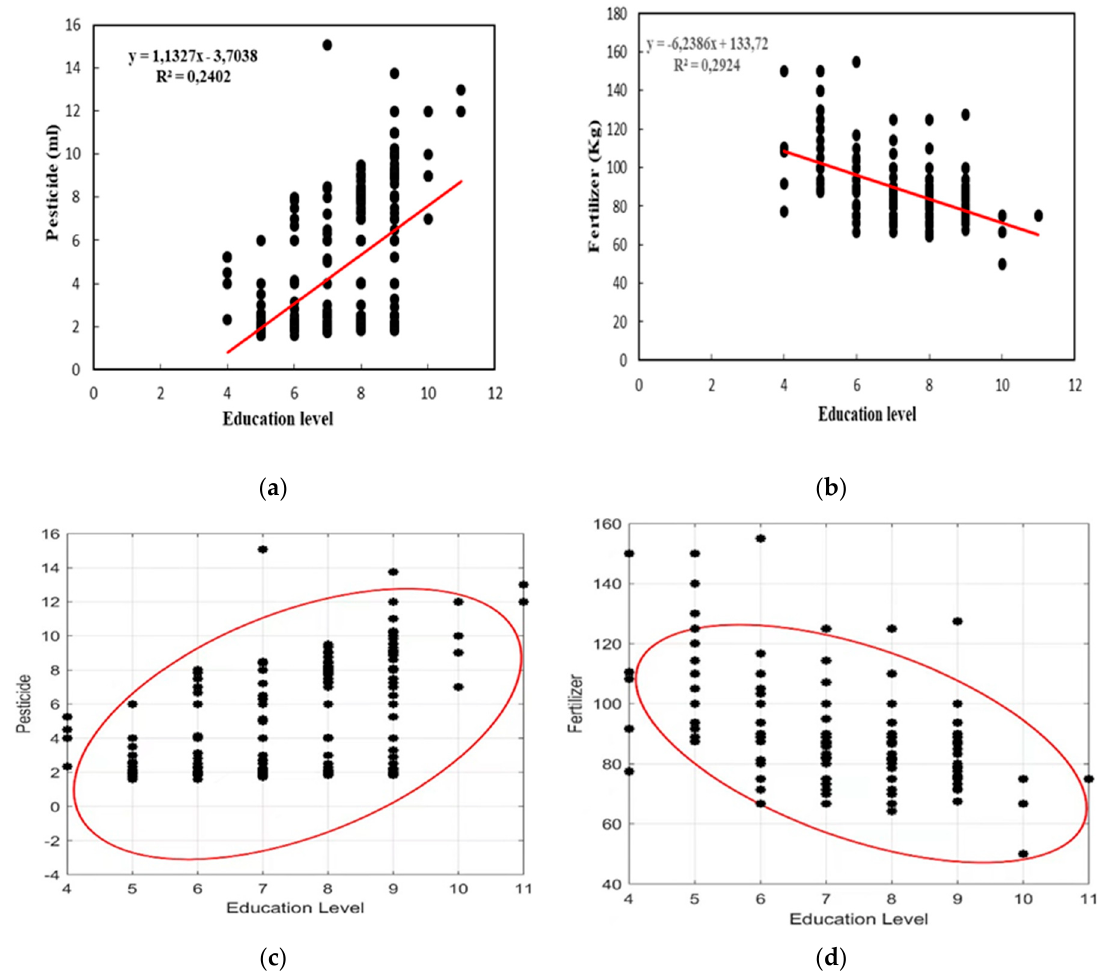
Figure 4. Matching correlation analysis and 95% confidence ellipse between chemical input and education level. ( a ) Matching between pesticide use and education level. ( b ) Matching between fertilizer use and education level. ( c ) Pesticide use and education level 95% confidence ellipse. ( d ) Fertilizer use and education level 95% confidence ellipse.